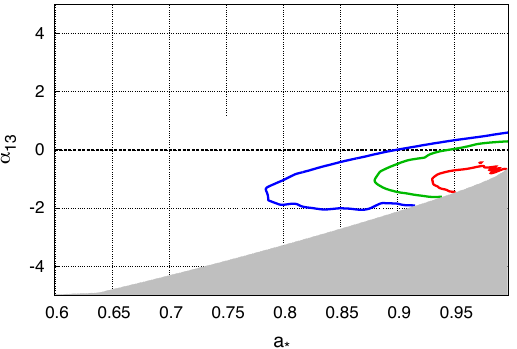
Figure 3. Constraints on the spin parameter a ∗ and the Johannsen parameter α 13 from the study in Ref. [59] of NuSTAR and Swift data of 1H0707–495. The red, green, and blue lines indicate, respectively, the 68%, 90%, and 99% confidence level curves for two relevant parameters. The grayed region is ignored because those spacetimes violate the constraint in Equation (6). Note that the constraints reported in Ref. [59] are slightly different because that study used an earlier version of RELXILL _ NK , and therefore the constraints reported here should be more reliable.